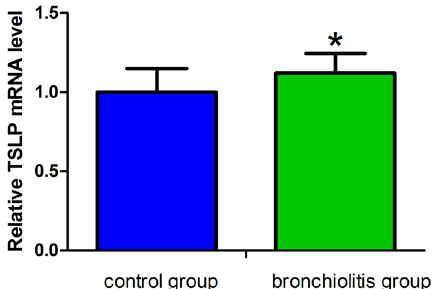
Figure 1. Comparison of TSLP mRNA expression levels in peripheral blood between control group and bronchiolitis group. The mRNA expression levels of TSLP in the bronchiolitis group were greater than control group (* P <